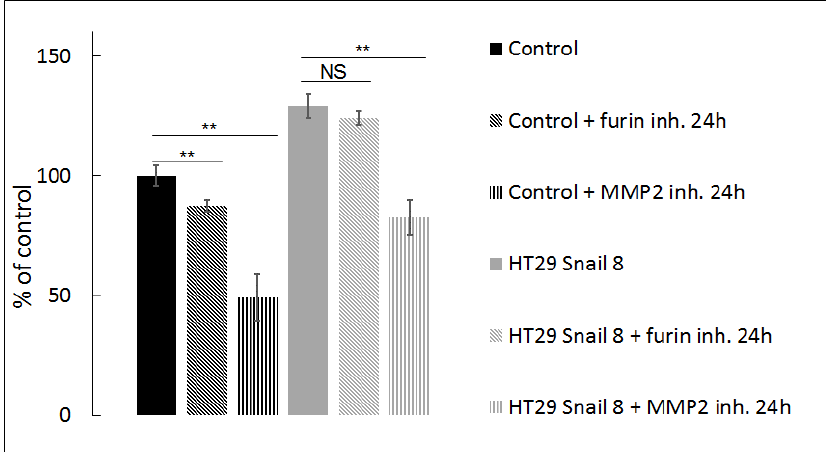
Figure 3. Gelatinolysis mediated by HT-29 with Snail overexpression measured by in-situ zymography. The pericellular proteolytic abilities of HT-29 cells with Snail overexpression were analyzed by measure of increase in FITC fluorescent intensity from digested DQ gelatine relativized as 100%. Furin inh.—25 µ M Furin Inhibitor I, MMP-2 inh—10 µ M ARP101. ** p > 0.005; to control cells presented as 100%. Furin inh. — 25 µM Furin Inhibitor I, MMP-2 inh — 10 µM ARP101. ** p > 0.005; NS — not statistically relevant.